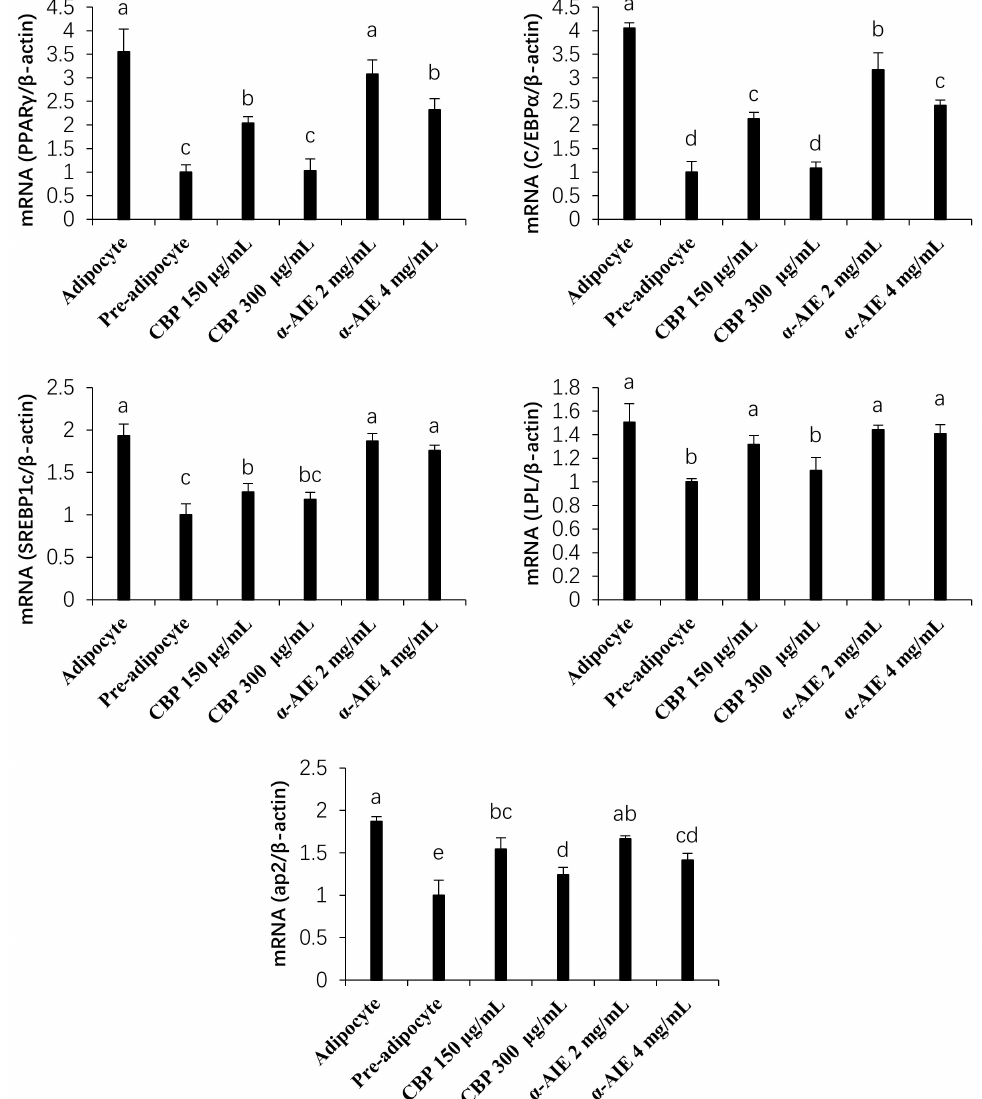
Figure 3. Effects of CBP and α -AIE on the mRNA expression level of peroxisome-proliferator-activated receptor families (PPAR γ ), CCAAT/enhancer binding protein (C/EBP α ), sterol-regulatory element binding proteins 1 c (SREBP1c), lipopro- tein lipase (LPL), and astragalus polysaccharides (ap2). The data were expressed as mean ± SD. Different letters mean significantly different ( p <